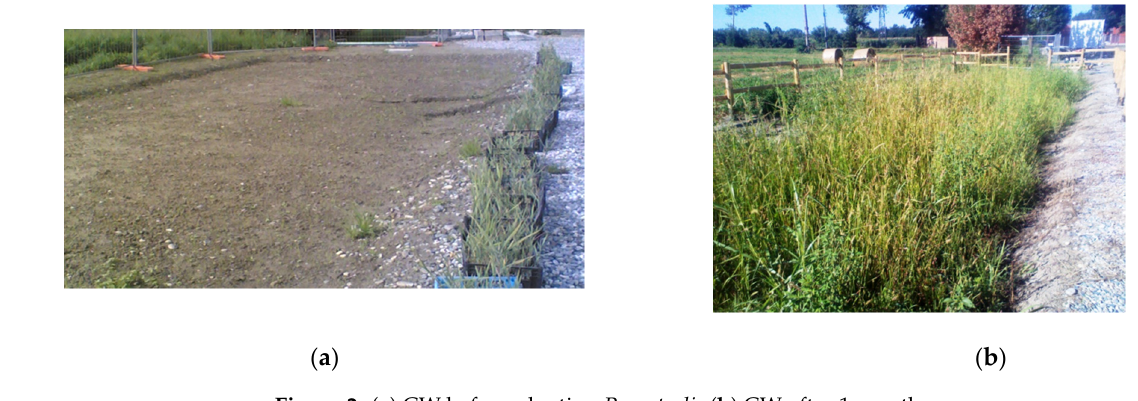
Figure 2. ( a ) CW before planting P. australis ( b ) CW after 1 month